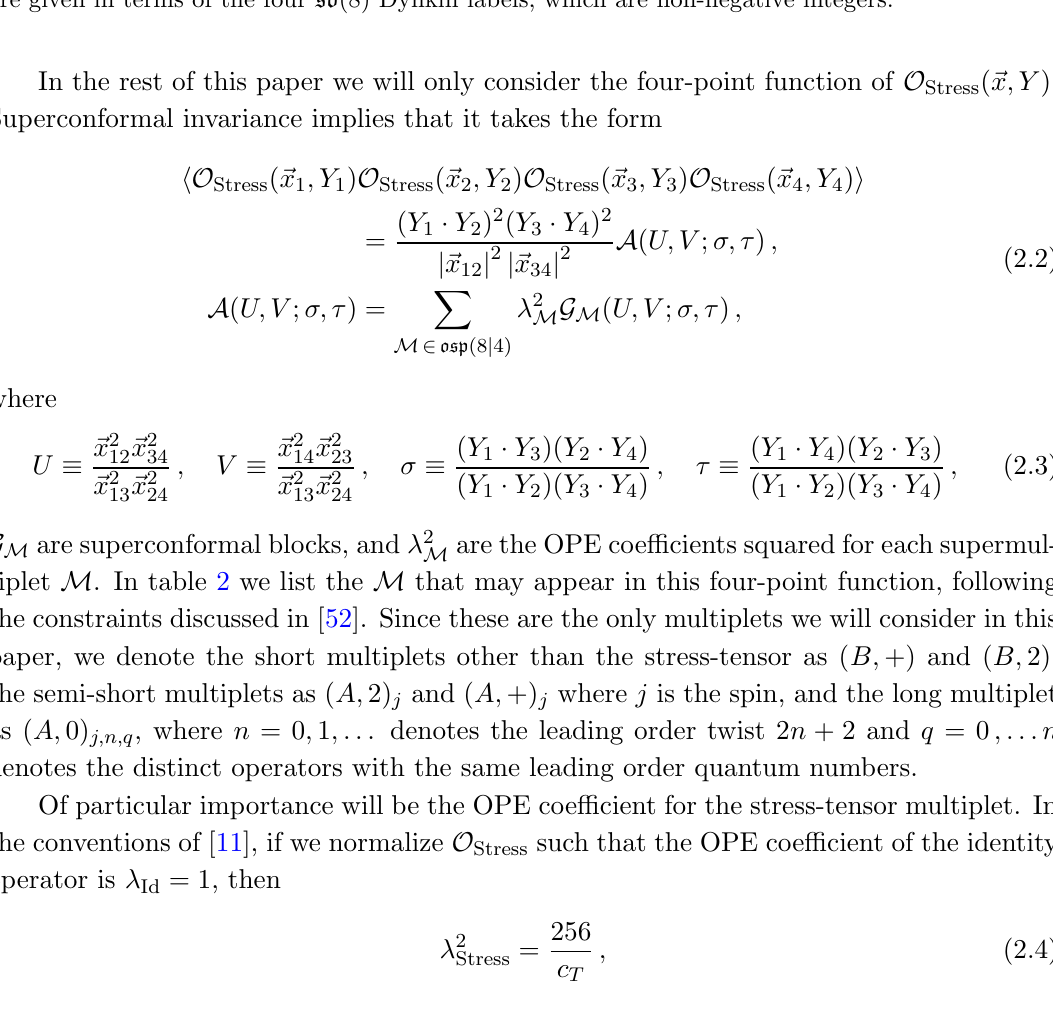
Table 1 . Multiplets of osp (8 j 4) and the quantum numbers of their corresponding superconformal primary operator. The conformal dimension (cid:1) is written in terms of (cid:1) 0 (cid:17) a 1 + a 2 +( a 3 + a 4 ) = 2. The Lorentz spin can take the values j = 0 ; 1 = 2 ; 1 ; 3 = 2 ; : : : . Representations of the so (8)